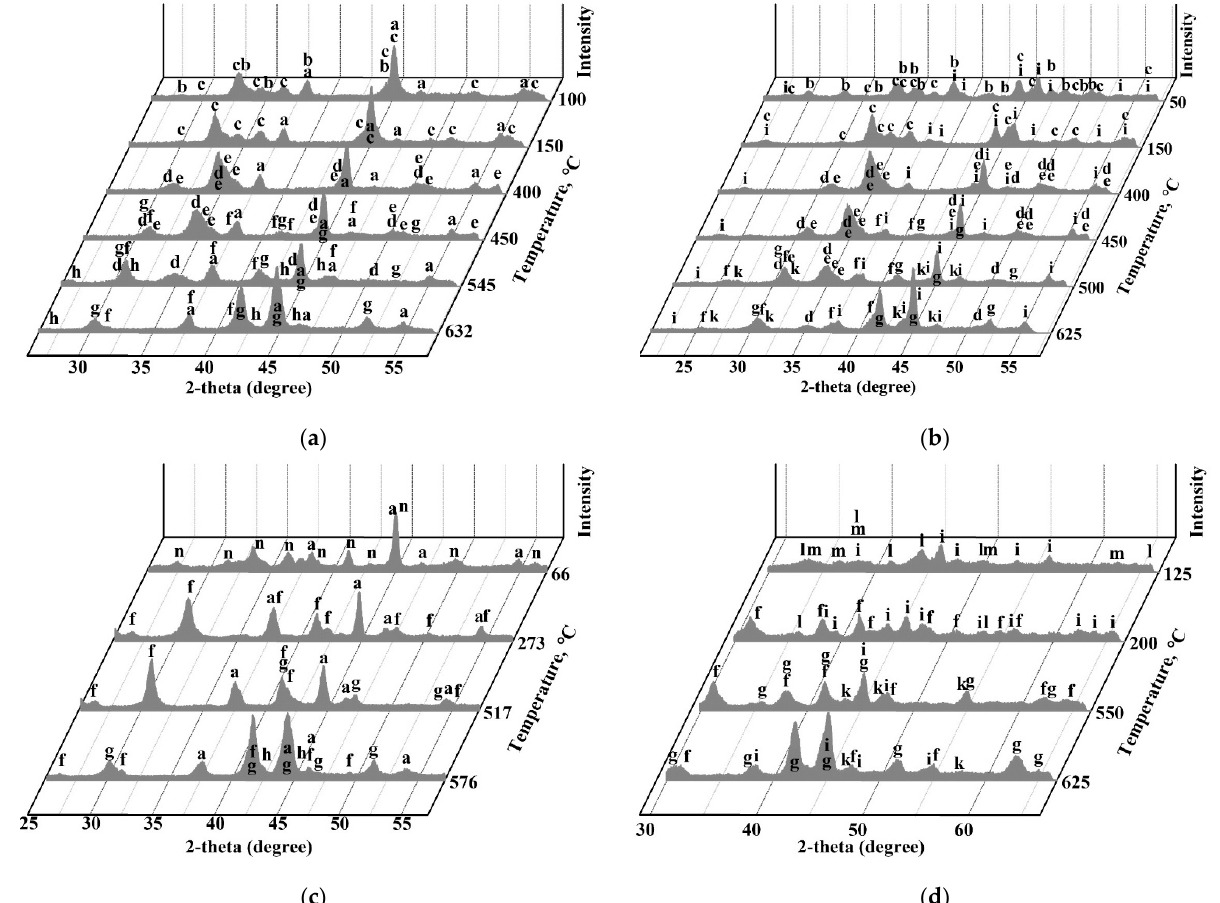
Figure 4. The XRD patterns obtained at different temperatures during TRXRD experiments using mixtures of 18.2% ZnFe 2 O 4 + 81.8% FeSO 4 ∙ 7H 2 O ( a ), 18.1% CuFe 2 O 4 + 81.9% FeSO 4 ∙ 7H 2 O ( b ), 17.2% ZnFe 2 O 4 + 82.8% FeSO 4 ∙ 7H 2 O ( c ) and 17.1% CuFe 2 O 4 + 82.9% FeSO 4 ∙ 7H 2 O ( d ), where a—ZnFe 2 O 4 ; b—FeSO 4 ∙ 4H 2 O; c—FeSO 4 ∙ H 2 O; d—FeSO 4 ; e—Fe(OH)SO 4 ; f—Fe 2 (SO 4 ) 3 ; g—Fe 2 O 3 ; h—ZnSO 4 ; i—CuFe 2 O 4 ; k—CuSO 4 ; l—Fe 2 (SO 4 ) 3 ∙ 5H 2 O; m—Fe 2 (SO 4 ) 3 ∙ 7H 2 O; n—Fe 2 (SO 4 ) 3 ∙ 9H 2 O.